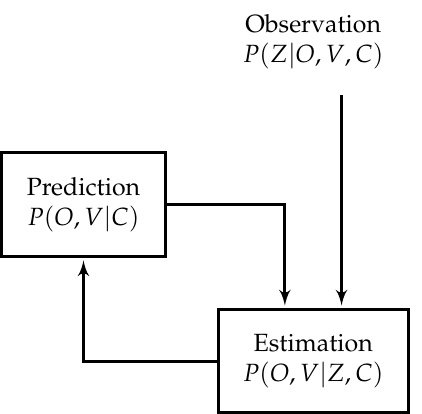
Figure 3. Diagram of prediction and estimation paradigm with the observation input [15]. Reproduced with permission from reference [15]. Copyright 2008 International Journal of Vehicle Autonomous Systems.